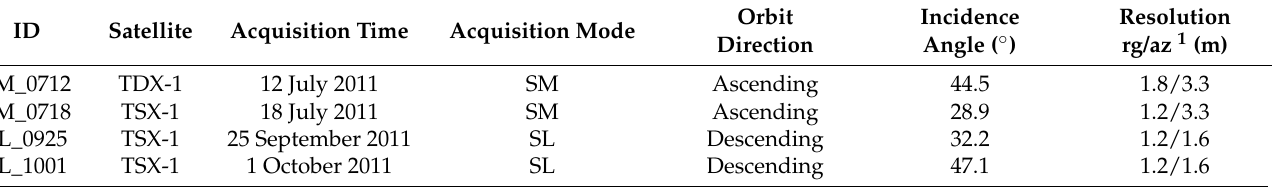
Table 1. Acquisition parameters of TerraSAR-X/TanDEM-X stereo